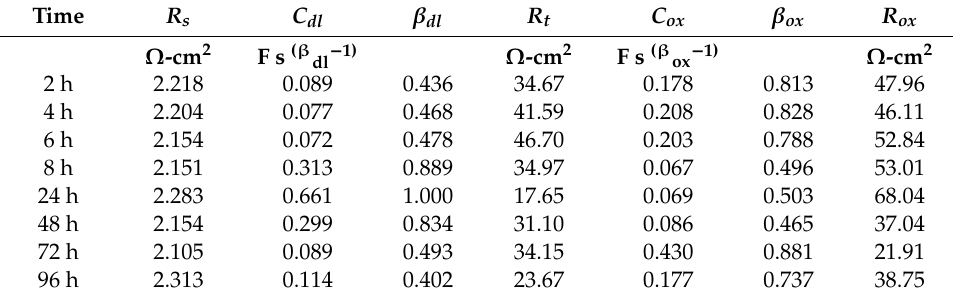
Figure 7. Nysquist diagram of stainless steel 304 layer in (KNa)NO 3 (solar salt) at 2 h, 4 h, 6 h, 8 h, 24 h, 48 h, 72 h and 96 h at 550 °C. Table 3. Fitting results of the impedance spectra of stainless steel 304 during corrosion in the presence of (KNa)NO 3 (solar salt) at 550 °C.